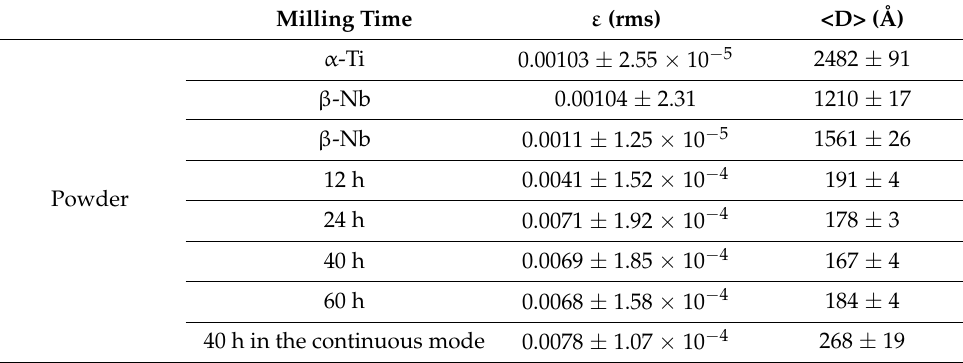
Table 2. Variation in crystallite size (<D>) and lattice strain ( ε ) of β phase for the precursors powders and TiNbMo powders with milling